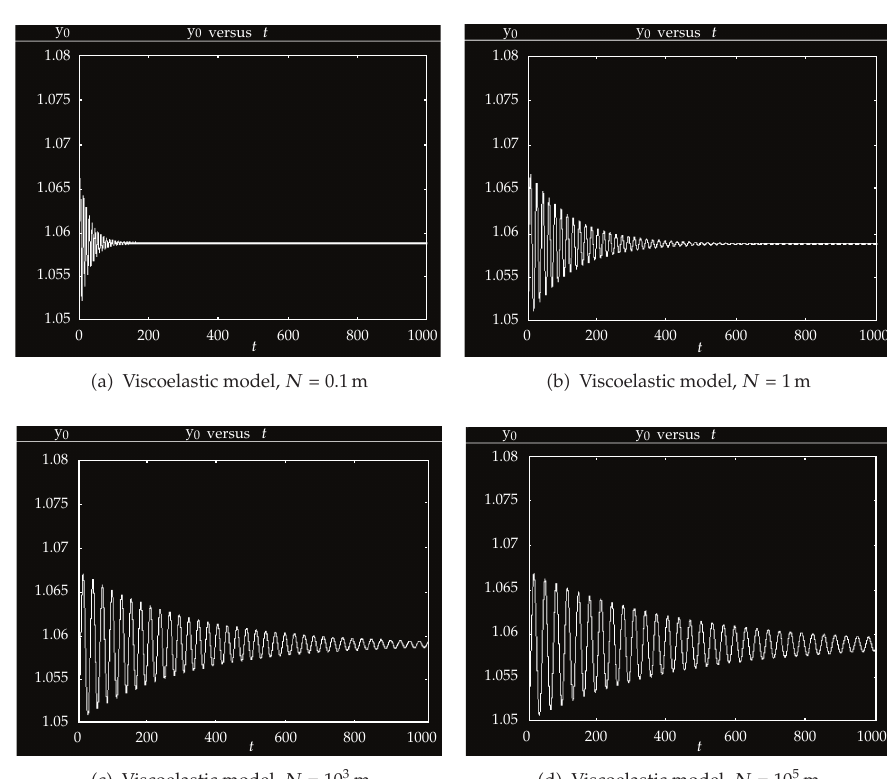
Figure 2: Stretch ratio with varying N